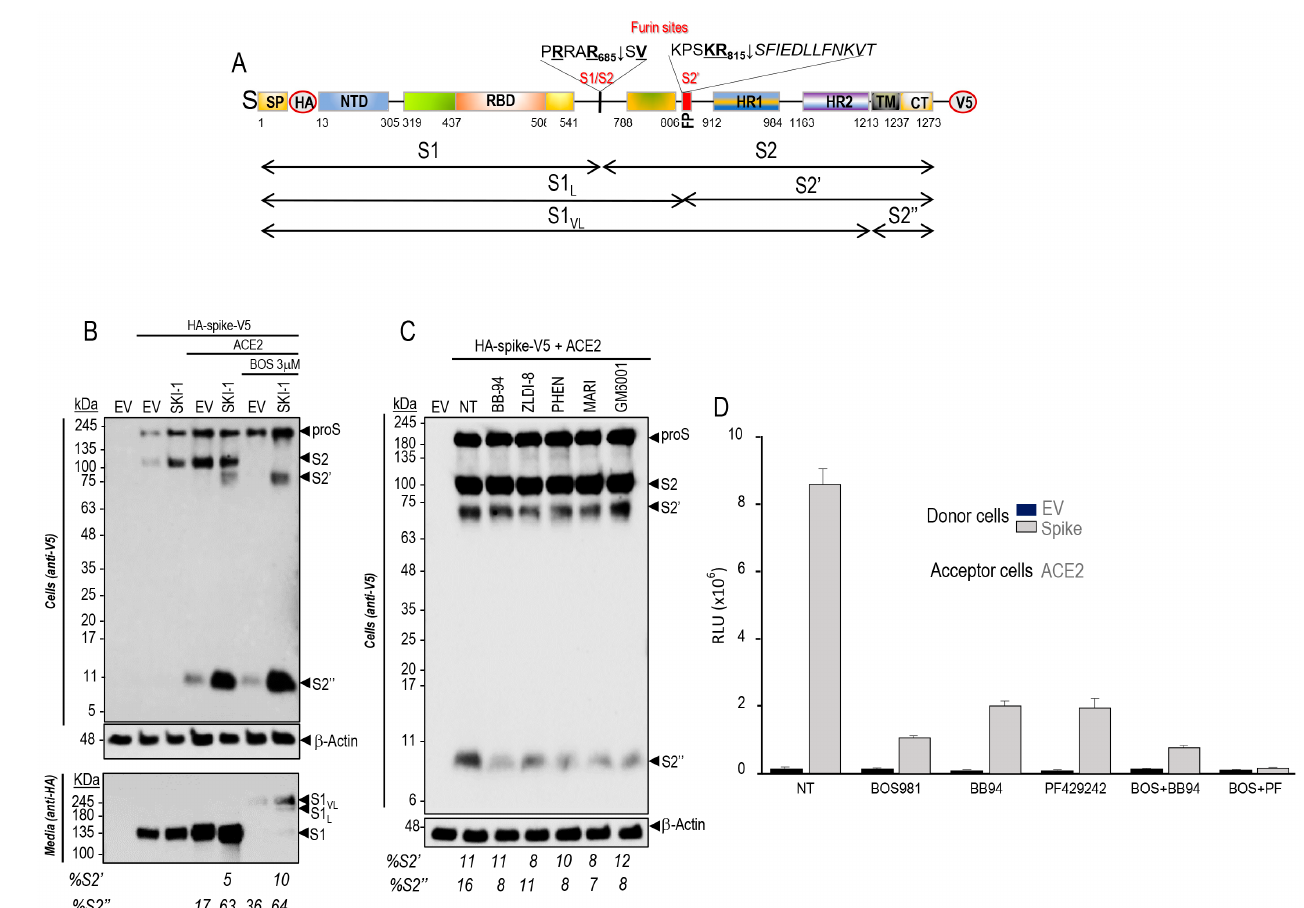
Figure 2. SKI-1 increases the cleavage at S2 ′ and sheds the spike glycoprotein. ( A ) Schematic repre- sentation of the primary structure of preproS, including its domains, the predicted furin-like S1/S2 site generating the S1- and S2-subunits, and the S2 ′ site preceding the fusion peptide (FP). The signal peptide (SP), N-terminal domain (NTD), receptor binding domain (RBD) to ACE2, the two heptad repeats HR1 and HR2, the transmembrane domain (TM), the cytosolic tail (CT) and the C-terminal V5-tag are indicated. ( B ) Western blot analyses of cell extracts and media from HeLa cells following co-transfection of cDNAs coding for doubly tagged WT proS with empty vector (EV) and/or that coding for ACE2 and SKI-1, and treatment with vehicle control (DMSO) or with 3 μ M of the furin inhibitor BOS-981. The cell extracts (upper panel) and the media (lower panel) were analyzed using anti-V5 and anti-HA mAbs, respectively. The sizes and schematics of the generated fragments are indicated in ( A ), and the migration positions in ( B ). ( C ) Hela cells transiently transfected with a cDNA encoding an empty vector (EV) or with one expressing the V5-tagged spike (S) glycoprotein were treated, 24 h post- transfection, with vehicle DMSO (NT) or with 1 μ M of the indicated metalloprotein- ase inhibitors. The cell extracts were analyzed by Western blotting using an mAb-V5. The percentage of shed S2” is indicated. ( D ) Naive Hela cells (donor) were transfected with vectors expressing either no protein (EV) or WT-spike (S). TZM-bl HeLa cells (acceptor) were transfected with a vector ex- pressing ACE2. After 48 h, donor and acceptor cells were co-cultured for 18 h in the absence (NT) or presence of the furin inhibitor (BOS-981, 3 μ M) and/or metalloproteinase inhibitor (BB, 1 μ M) and SKI-1 inhibitor (PF429242, 10 μ M). The extent of fusion is represented as relative luminescence units (RLU).